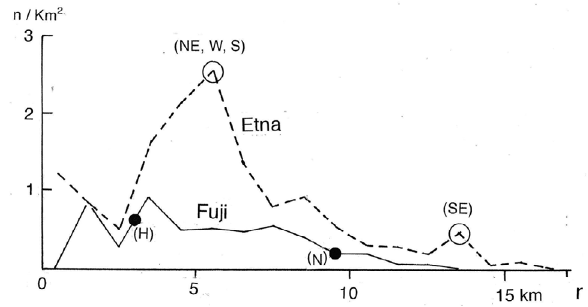
Figure 3. Spatial density distribution (n/km 2 ) of parasitic vents on Fuji and Etna against radial distance from the central axes of the volcanoes. (H) and (N) are the historical eruptions of Fuji. (NE, W, S) and (SE) show the radial directions of the predominant zones on Etna.